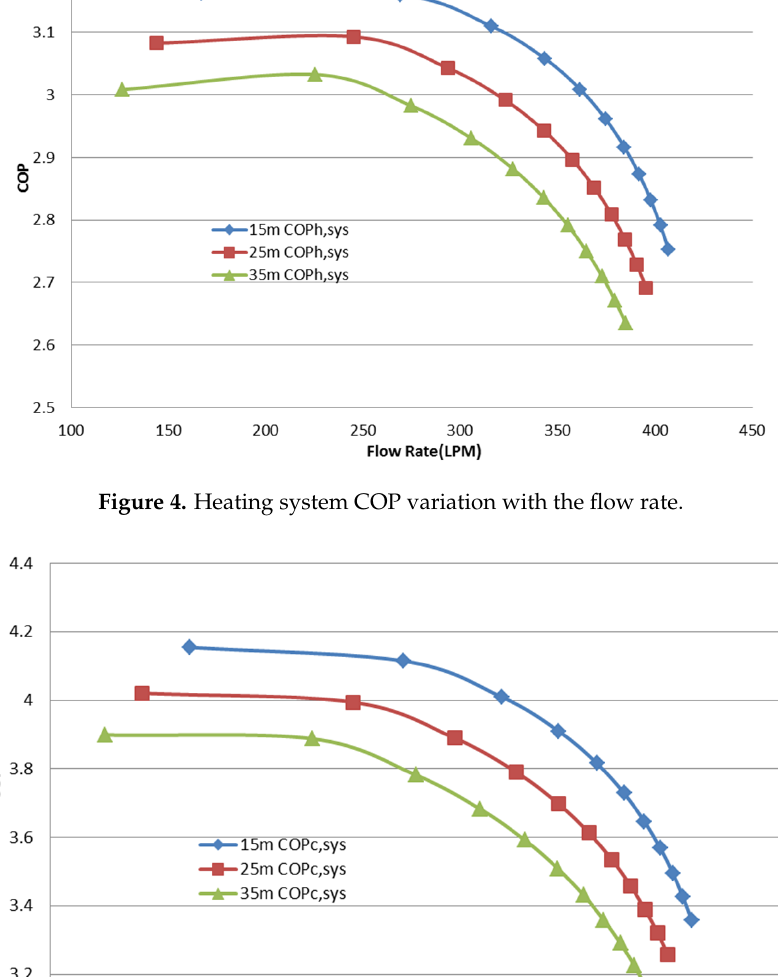
Figure 6. System heating COP reduction compared to heat pump unit COP.